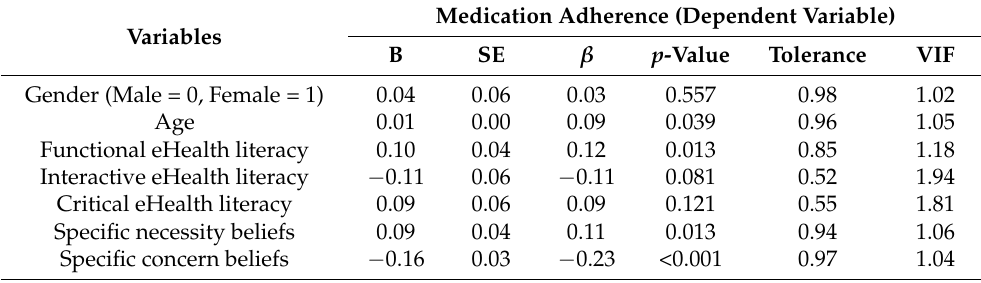
Table 3. Multiple regression model (enter method) using gender, age, eHealth literacy and beliefs about medicine as independent